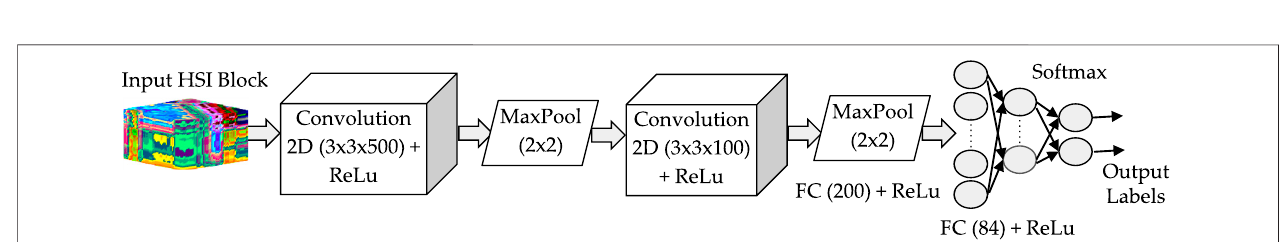
FIGURE 14 | CNN architecture for classi fi cation.